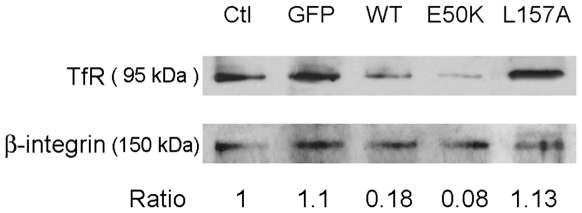
Overexpression of wild type and E50K optineurin, but not L157A mutant, alters the surface TfR level in RPE cells.Cells were transfected to express GFP, as well as wild type (WT)-, E50K-, and L157A-optineurin-GFP. Surface TfR was detected by Western blotting with anti-TfR after surface protein biotinylation and isolation of biotinylated proteins. The level of surface TfR was normalized to that of a well known cell surface protein, β1-integrin. The ratios of TfR to β1-integrin are presented. Ctl, nontransfected control RPE cells.